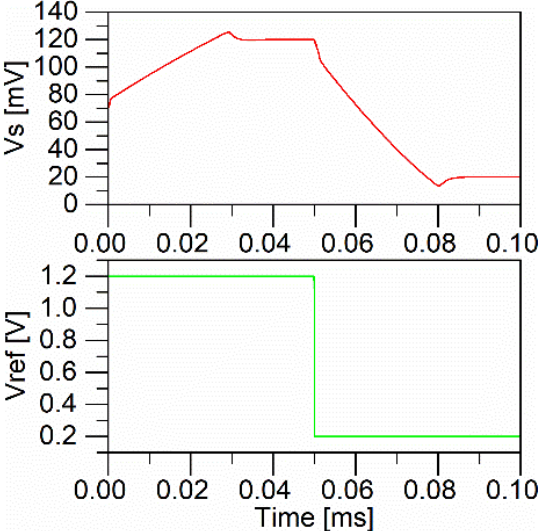
Figure 13. Transient response of the current source when C5 equals 1 uF.